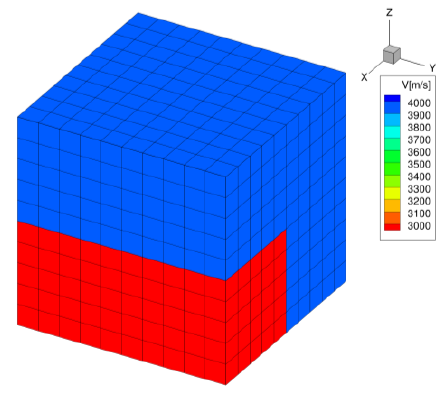
Figure 5. A numerical model for the verifications.